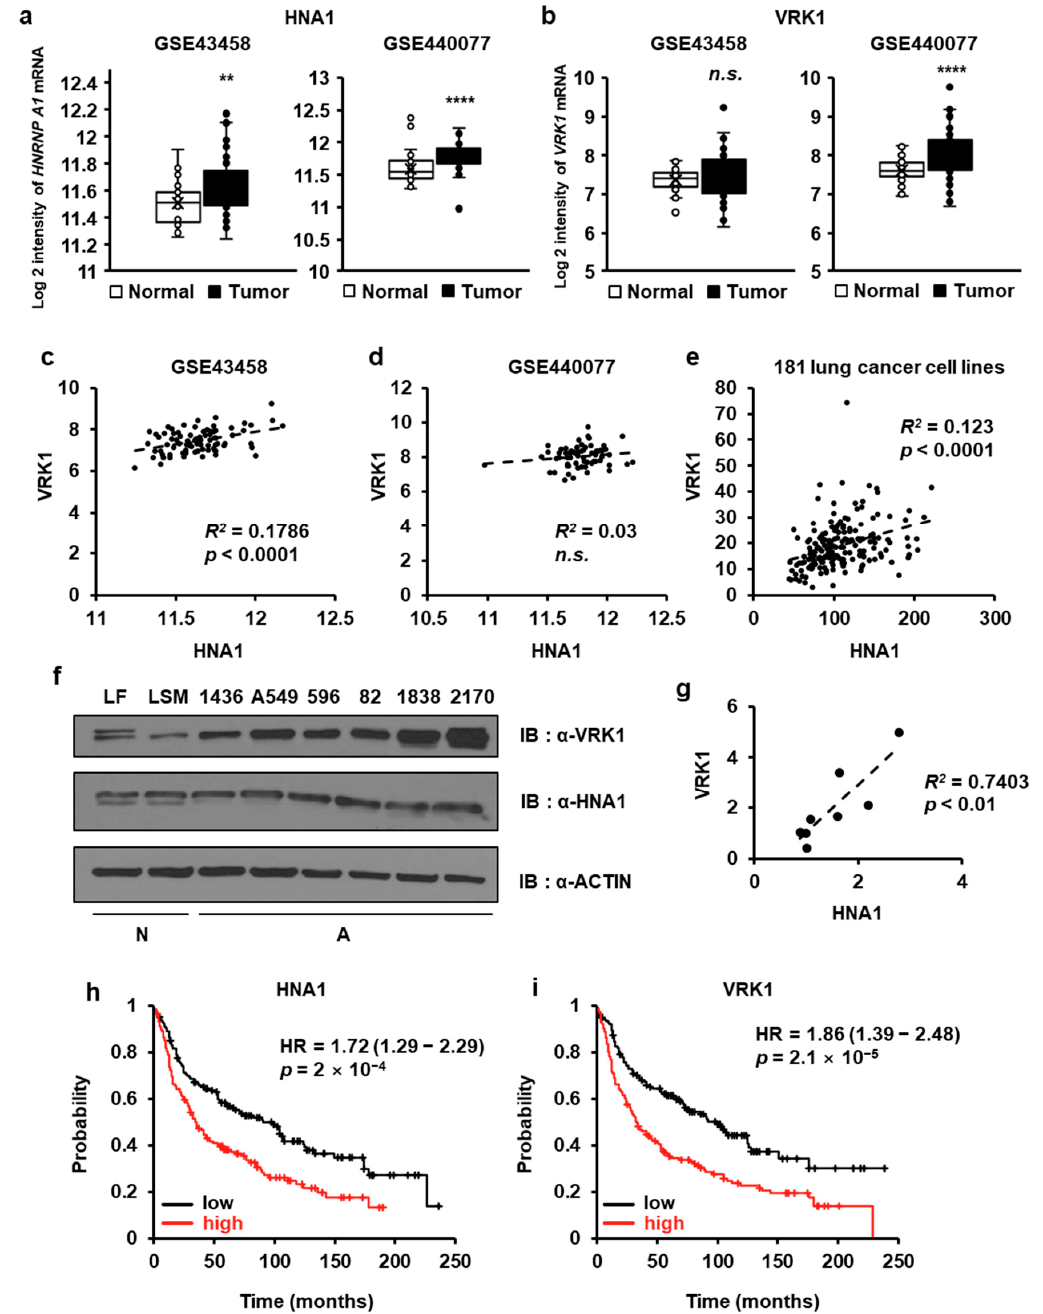
Figure 8. HNRNP A1 is upregulated in lung cancer. ( a , b ) Analysis of publicly available TCGA lung cancer data sets revealed a significant up-regulation with HNRNP A1 expression but not with VRK1 expression in lung cancer. ** p < 0.01, **** p < 0.0001, n.s., not significant. ( c – e ) Co-expression analysis between HNRNP A1 and VRK1 in different lung cancer data sets are shown. ( f ) Cell lysates of human normal lung cells (lung fibroblast (LF), lung smooth muscle (LSM)) and a panel of lung cancer cell lines (NCIH1436 (1436), A549, NCIH596 (596), NCIH82 (82), NCIH1838 (1838), NCIH2170 (2170)) were probed for the expression of VRK1 and HNRNP A1 using specific antibodies. N, normal; A, adenocarcinoma. ( g ) Band intensities were measured by densitometry using Image J. VRK1 and HNRNP A1 band intensities were normalized to those of ACTIN. Co-expression analysis between HNRNP A1 and VRK1 protein levels is shown. ( h , i ) Online survival analysis software (Kaplan-Meier plotter) was used to assess the prognostic value of HNRNP A1 and VRK1 expression in lung cancer patient. HNRNP A1 and VRK1 overexpression correlates with poor prognosis of lung cancer patients.